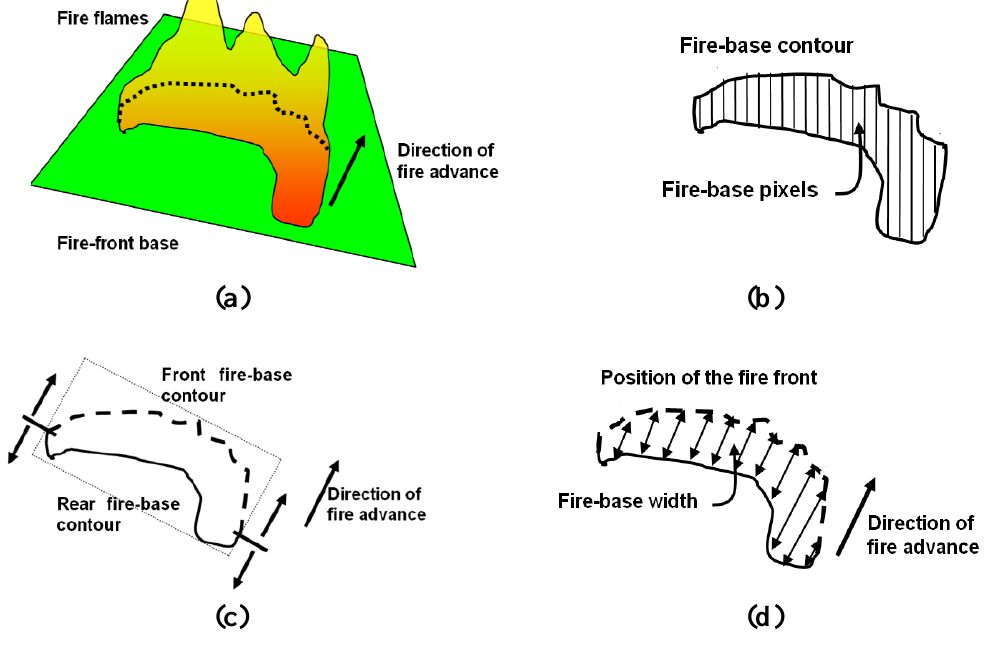
Figure 7. Extraction of features from infrared images: (a) fire-front, (b) once the fire-base has been segmented, it is easy to identify the fire-base contour, (c) taking into account the direction of fire advance, it is simple to differentiate between the front and the rear fire-base contours, (d) the fire-base width is computed as the distance between pixels on the front and the rear contours along the direction of fire